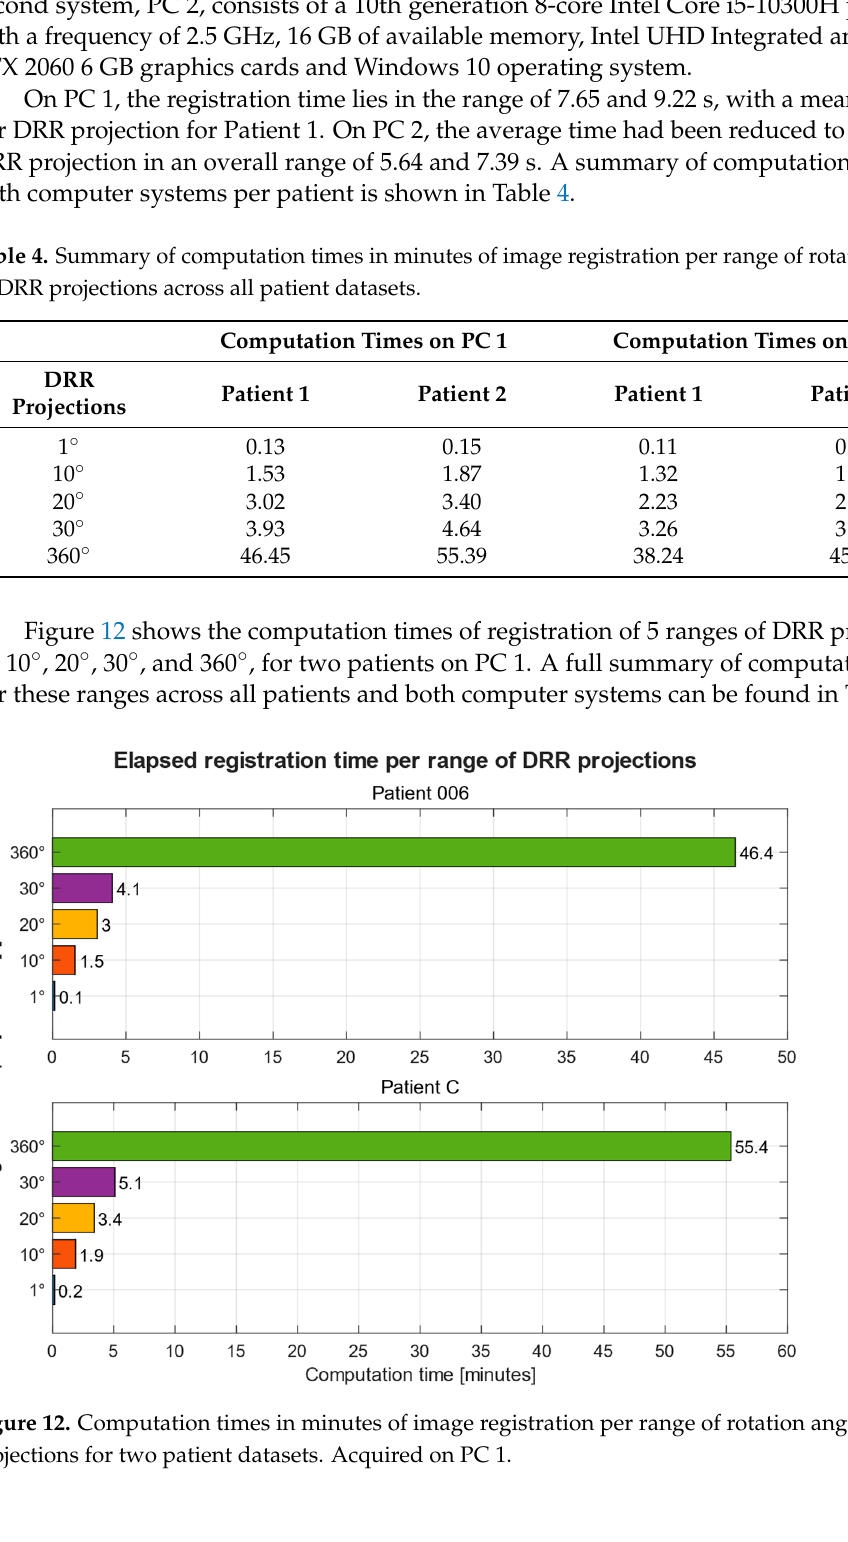
Table 3. Summary of highest similarity results and their DRR projection per patient.